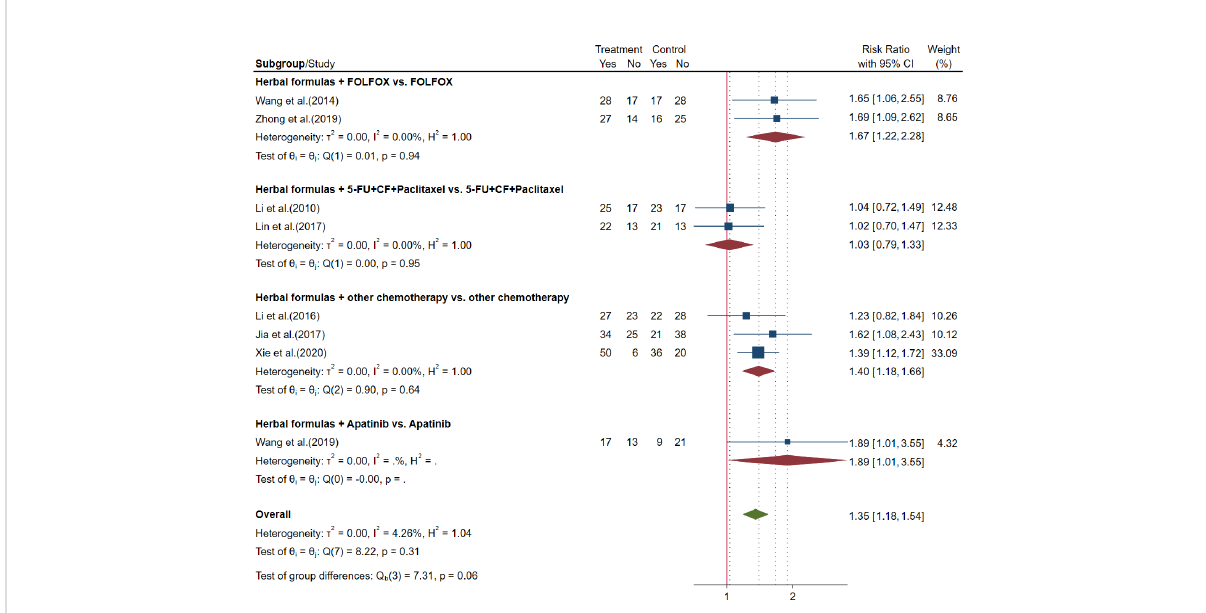
FIGURE 6 Forest plot of objective response rate (ORR) in advanced gastric cancer (GC).